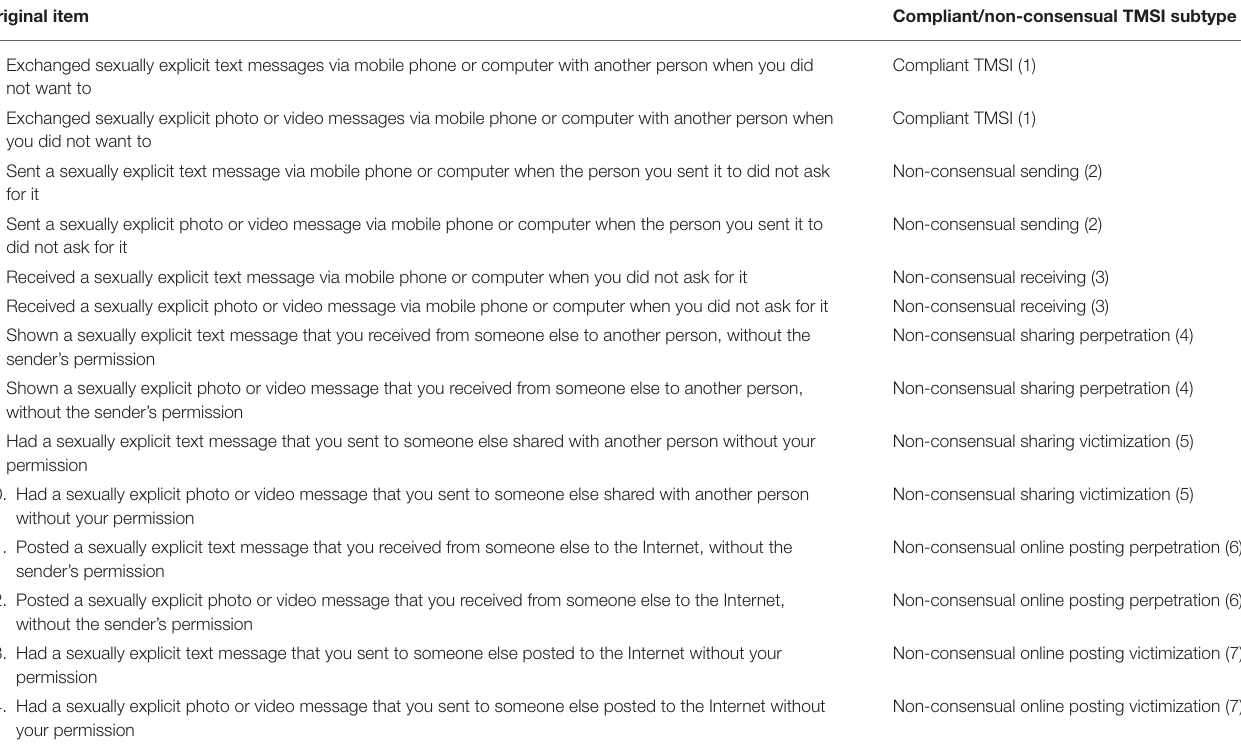
TABLE 2 | Items comprising our measure of compliant and non-consensual TMSI experiences and their corresponding TMSI subtype. Original